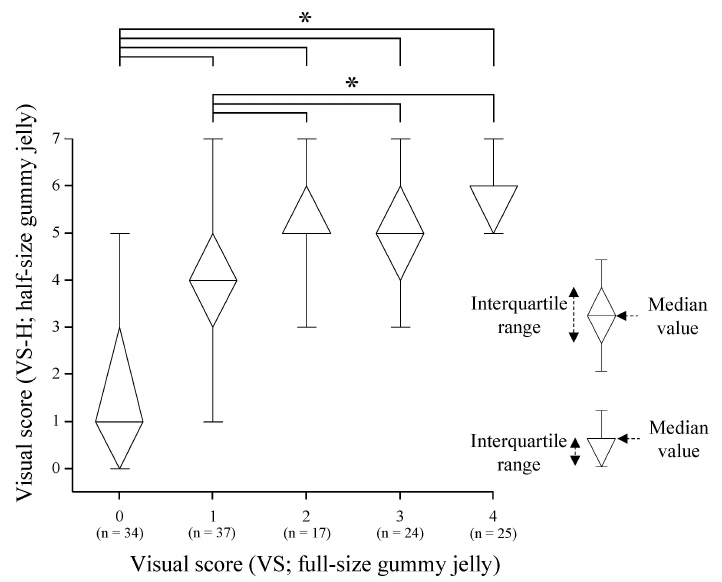
Figure 4. Differences in visual score (VS-H; half-size gummy jelly) among the different visual score groups (VS; full-size gummy jelly) . VS-H significantly increased as VS increased from 0 to 2. There were no significant differences in VS-H and VS values of 2 to 4. Kruskal–Wallis test and post hoc test with Bonferroni’s correction (*: p <